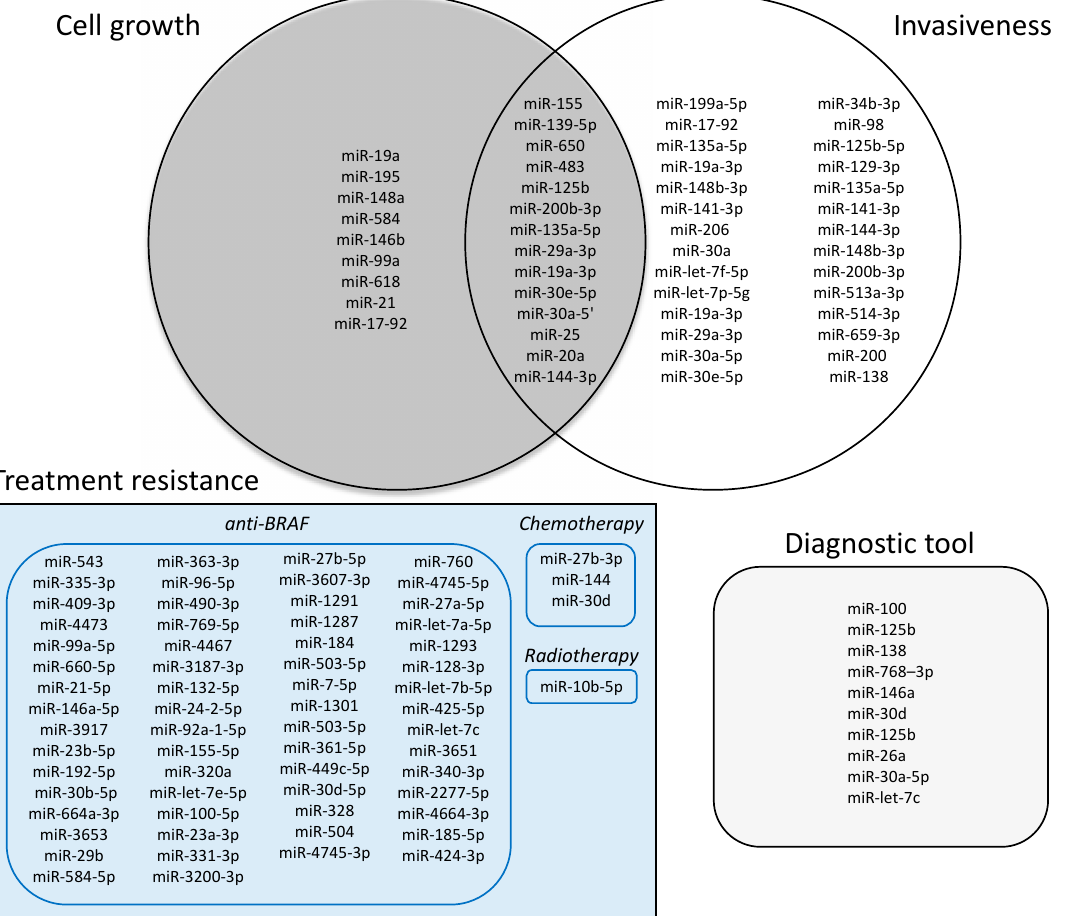
Figure 2. miRNA that were discovered in ATC according to their function. Beyond miRNA, growing evidence is showing the role of lncRNAs in cancer. lncRNA are RNAs longer than 200 nucleotides that do not encode proteins but regulate gene expression, splicing and nucleation of subnuclear domains [49]; moreover, lncRNAs may have cytoplasmic functions, such as miRNA sponging, interaction with signaling proteins, and further modulation of mRNA translation [49]. In ATC, lncRNAs may regulate tumor growth [84,85], invasiveness [86], and both tumor growth and invasiveness [87–91]; they can also regulate cancer sensitivity to treatments [92]. In particular, lncRNA PTCSC3 was described at low levels both in ATC tissue and cell lines and it was demonstrated that its upregulation inhibited the resistance to doxorubicin by suppressing stem cell proprieties